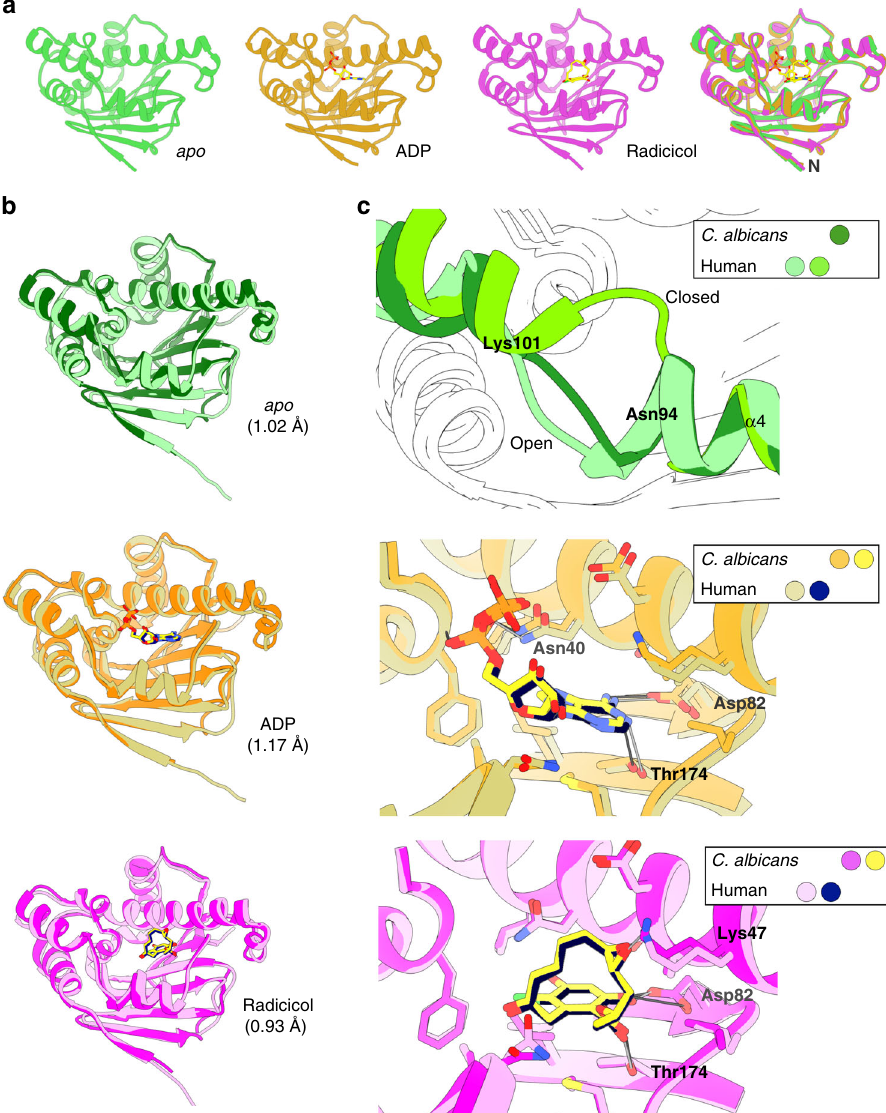
Fig. 1 Structure of C. albicans Hsp90 nucleotide-binding domain (NBD) in apo and ligand-bound states. a Ribbon representation of crystal structures determined for C. albicans Hsp90 NBD in the non-ligand-bound or apo state (green), ADP-bound state (yellow) and in complex with radicicol (magenta). The ligands ADP and radicicol are represented as sticks and color-coded according to their heteroatom composition. An overlay of all three structures is also presented at the far right. b Ribbon representation of crystal structures determined for C. albicans NBD (darker shades) in the non-ligand-bound or apo state (top panel, green), ADP-bound state (middle panel, orange), and in complex with radicicol (lower panel, magenta). Structures for human Hsp90 NBD (lighter shades) are overlaid. The ligands ADP and radicicol are represented as sticks and color-coded according to their heteroatom composition. The main-chain atom r.m.s.d. for the superpositions is indicated in parentheses for each overlaid pair. c Detailed view of superpositions encompassing the region of the ligand-binding site. The top panel provides a detailed view of the region Asn94 – Lys 101 in C. albicans and human apo structures, two human conformations are shown open (lighter green; PDB id. 1YES) and closed (darker green; PDB id. 1YER). The middle and bottom panels depict a detailed view of the residues which hydrogen-bond with ADP and radicicol, respectively, in both C. albicans and human Hsp90